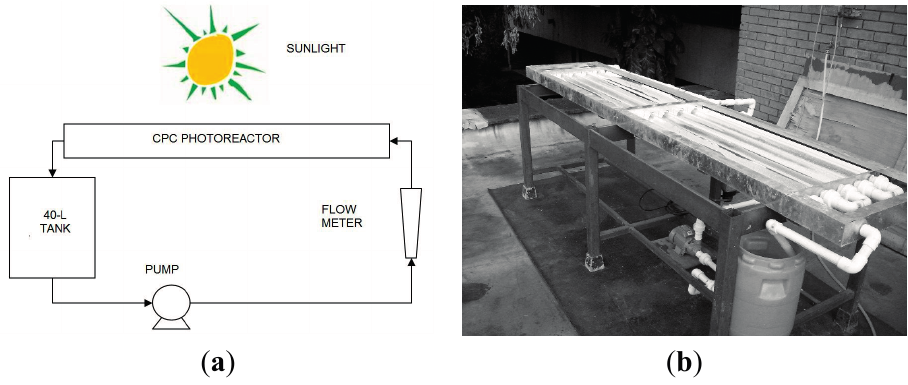
Figure 12. Pilot-scale solar CPC: ( a ) scheme of experimental setup and ( b ) photocatalytic reactor (Universidad del Valle,